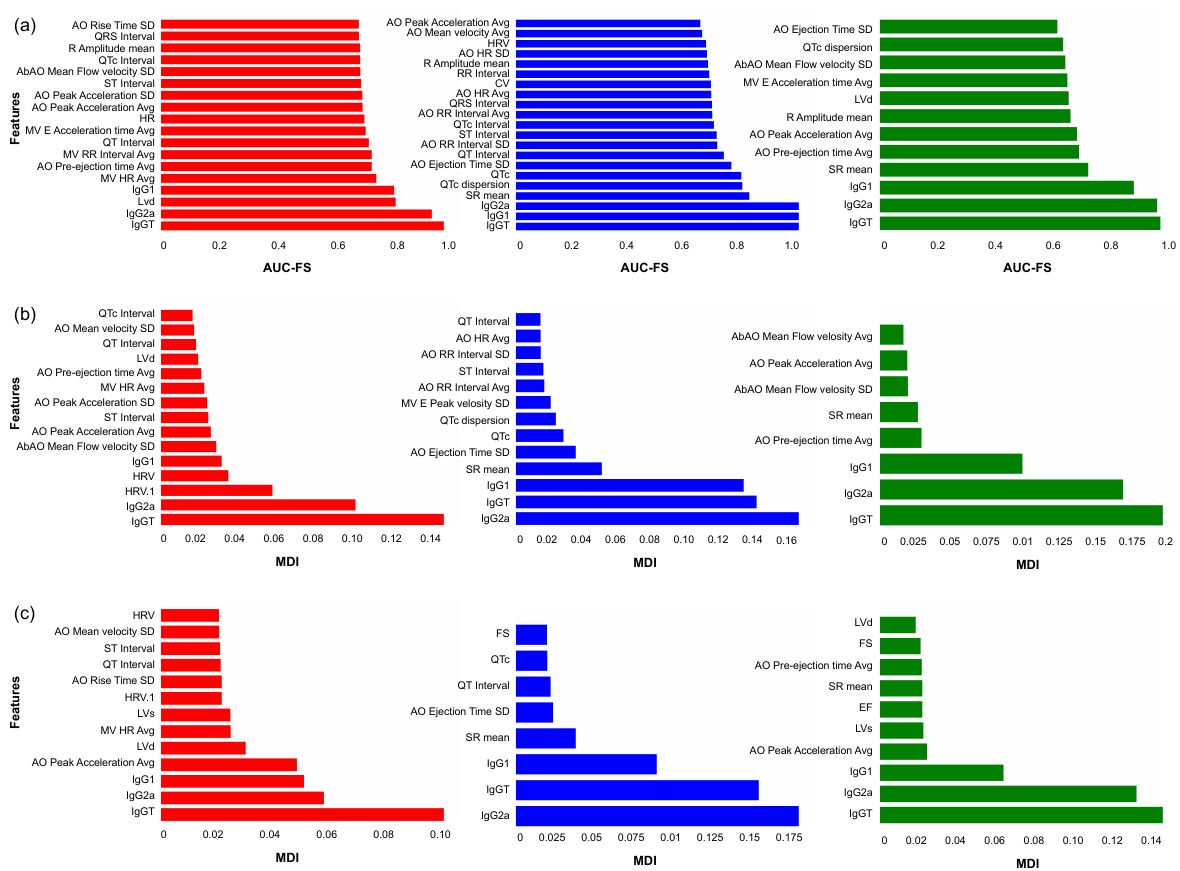
Figure 5. Multimodal Feature Selection Analysis for acute phase (red), chronic phase (blue), and general case of T. cruzi infection: ( a ) AUC-FS, ( b ) Random Forest, and ( c ) Extremely Randomized